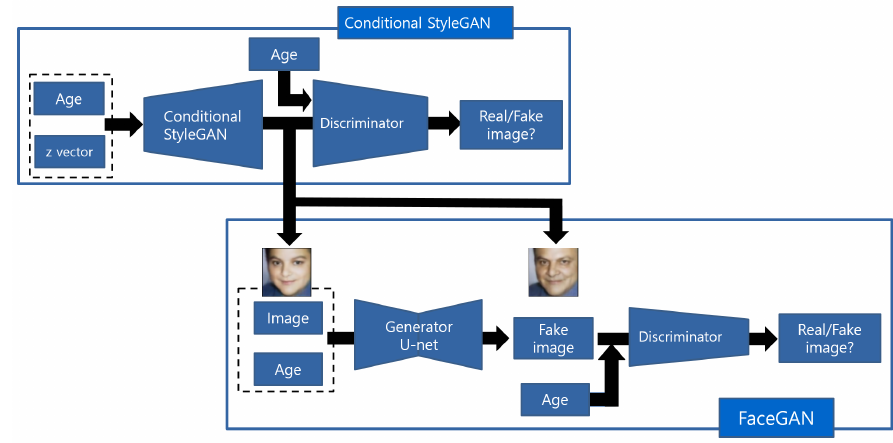
Figure 3. The proposed SS-FaceGAN